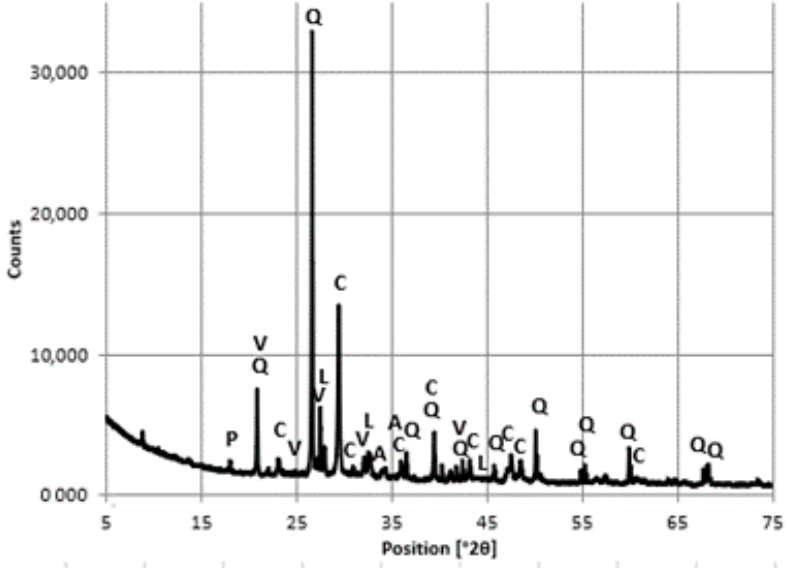
Figure 17. A diffractogram of the cement slurry from the concrete samples - bottom floor slab layer. Designation: P—portlandite, V—vaterite, A—aragonite, C—calcite, Q—quartz, L—larnite.